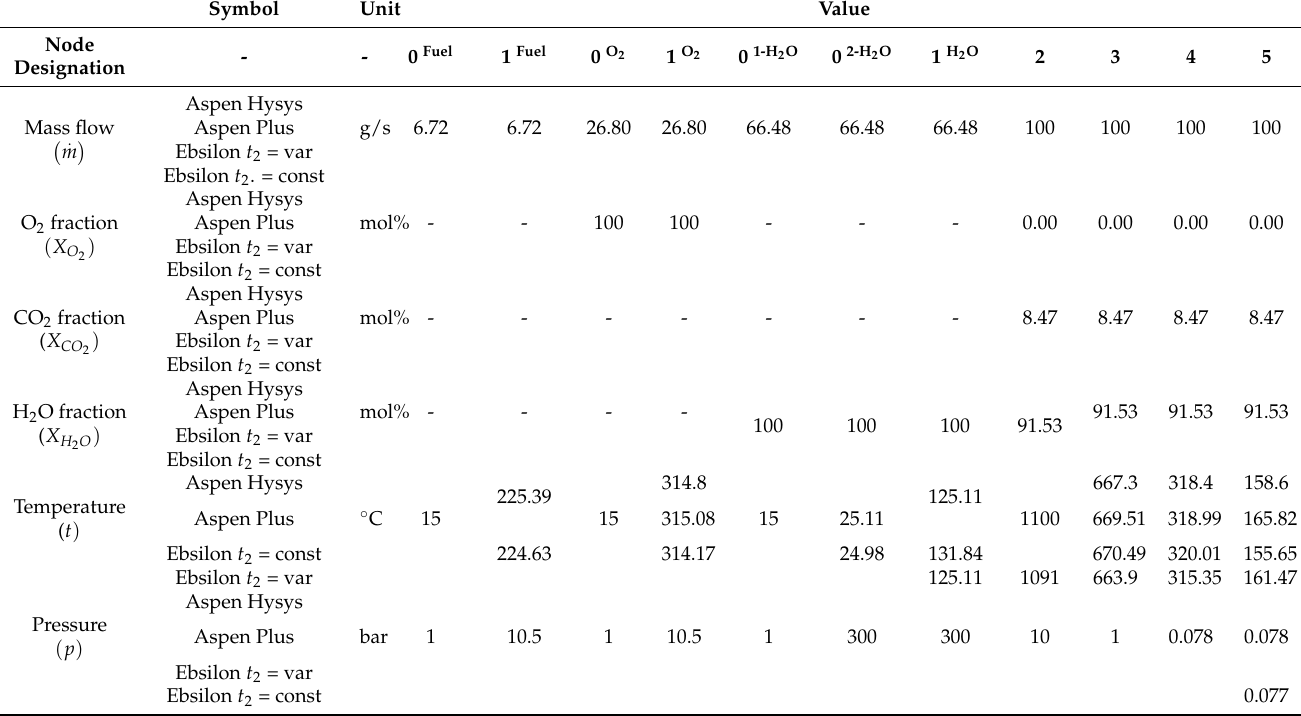
Table 8. Cycle nodal points on basis of